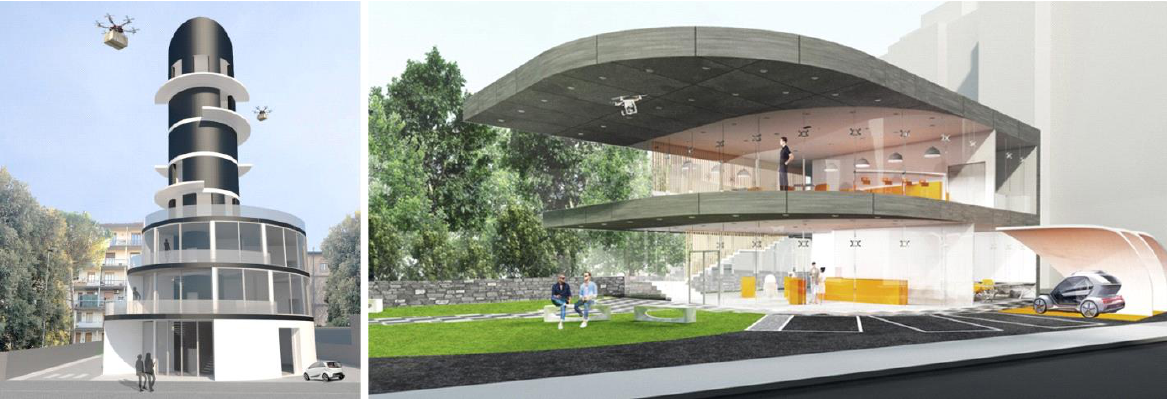
Figure 9.1 Martina Roncolini and 9.2 Grata Viola, Florenze Smart City, Florence School of Architecture,